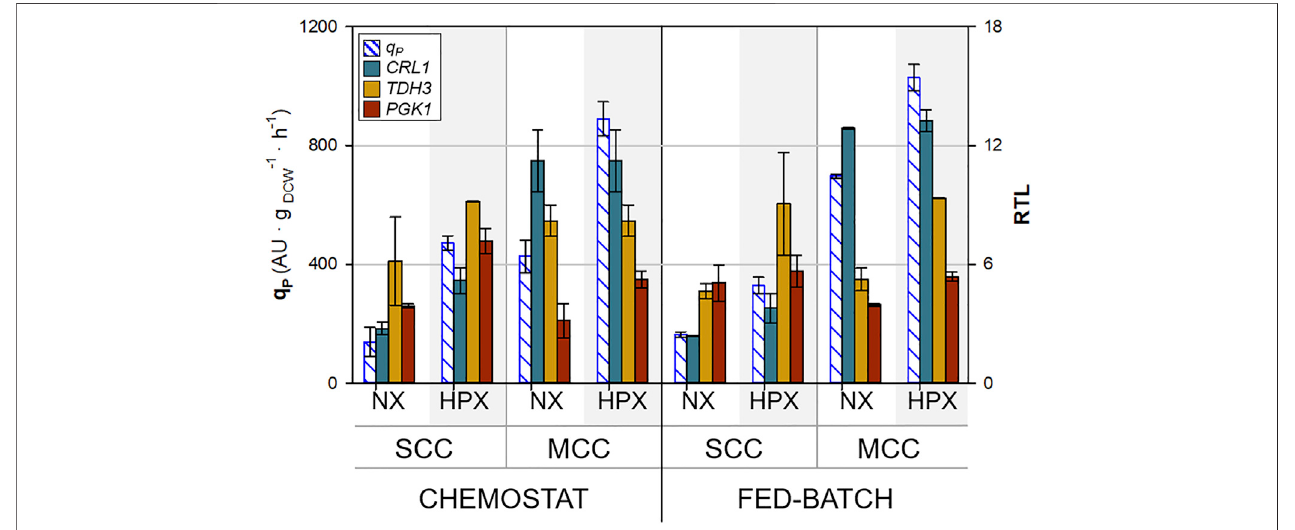
FIGURE 5 | Comparison of q P and relative transcript levels (RTL) of key genes under all conditions tested. Error bars represent the SD of all samples belonging to the same group of culture conditions (hypoxic and normoxic).